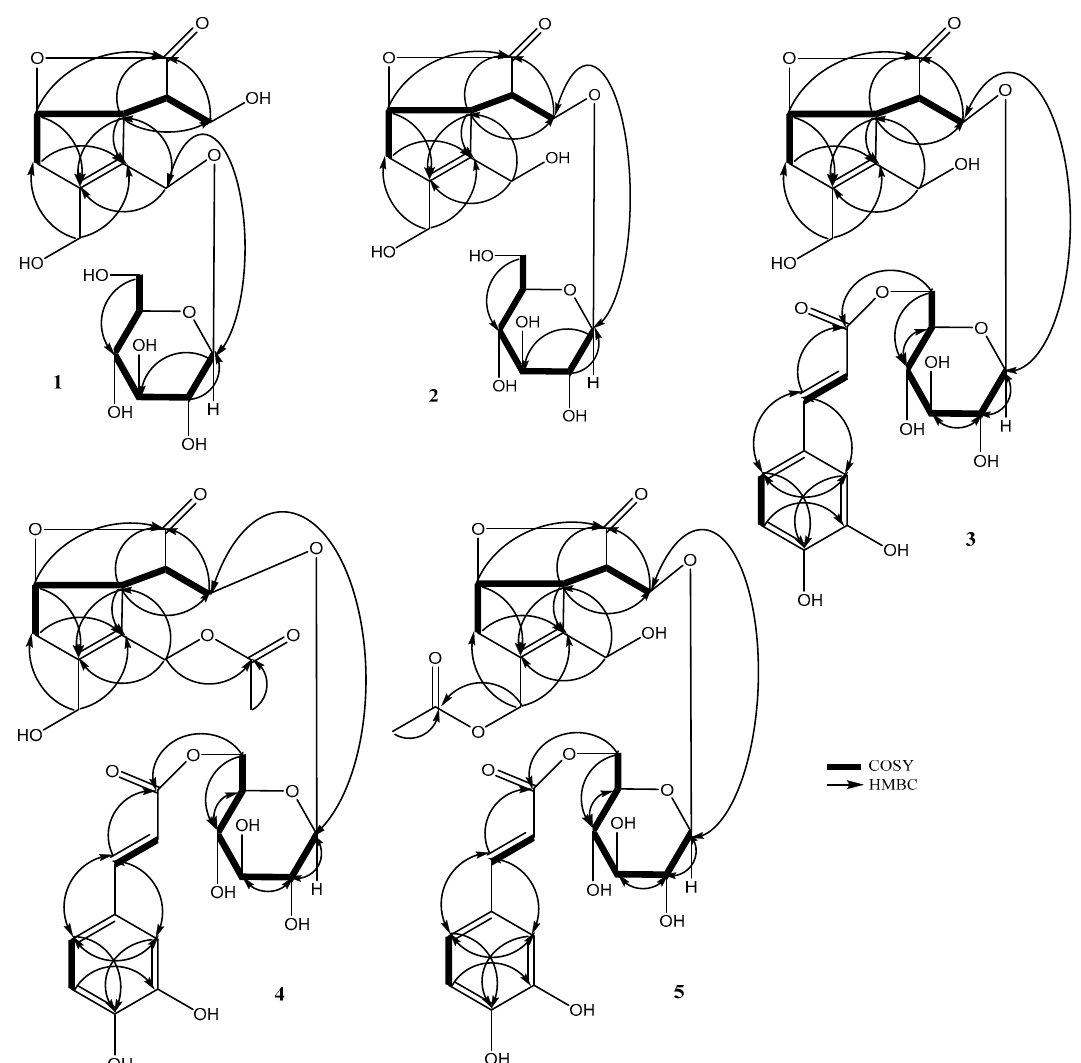
Figure 2. Correlation spectroscopy (COSY) and heteronuclear multiple bond connectivity correlation (HMBC) correlations of 1 – 5 .